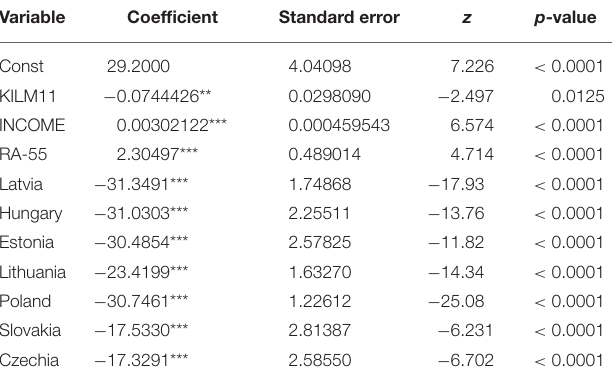
TABLE 14 | GMM model 4, dependant variable—SP18(m).